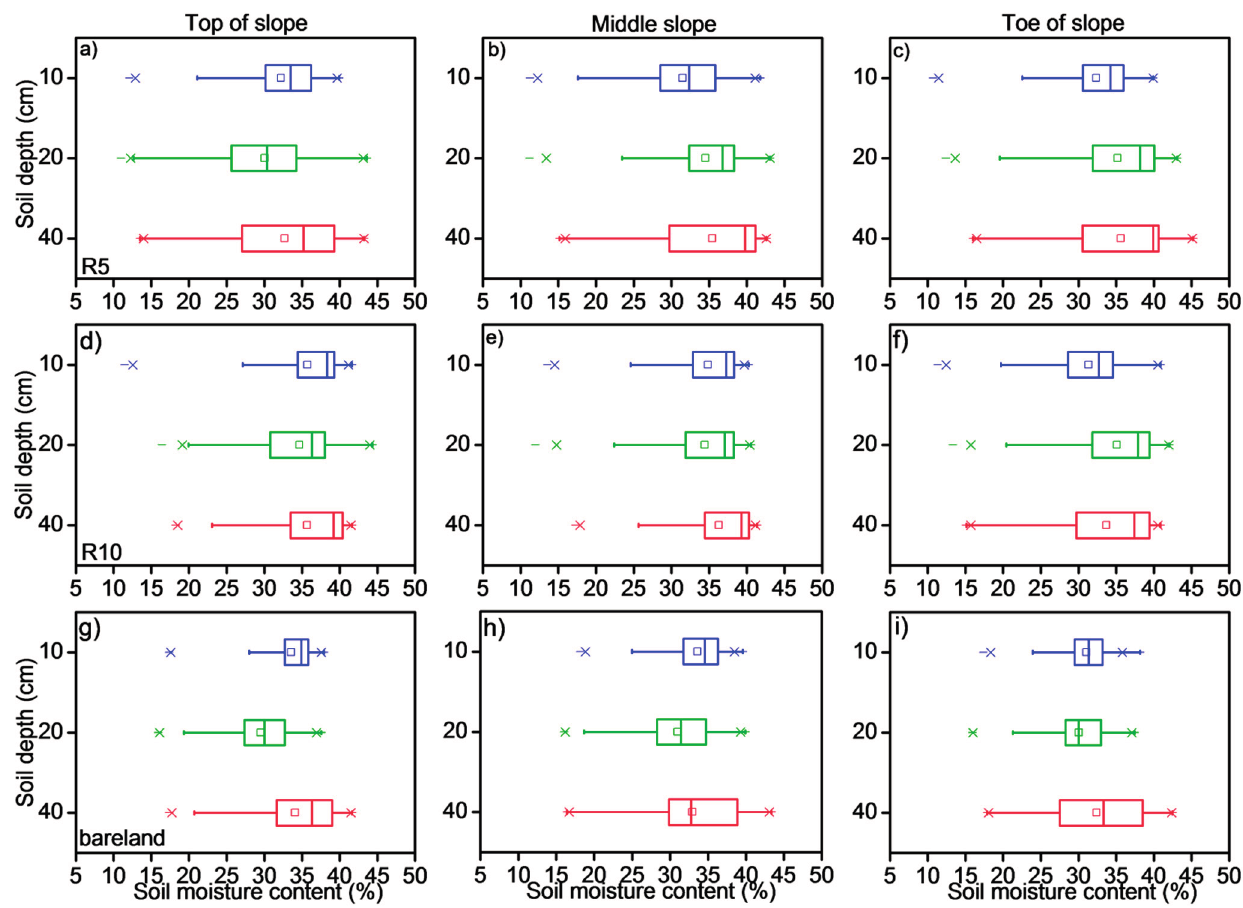
Figure 6. Boxplot of soil moisture at each soil layer (10 cm, 20 cm and 40 cm) and different slope positions for both grassland and bare land treatments during the entire growth stage (April to